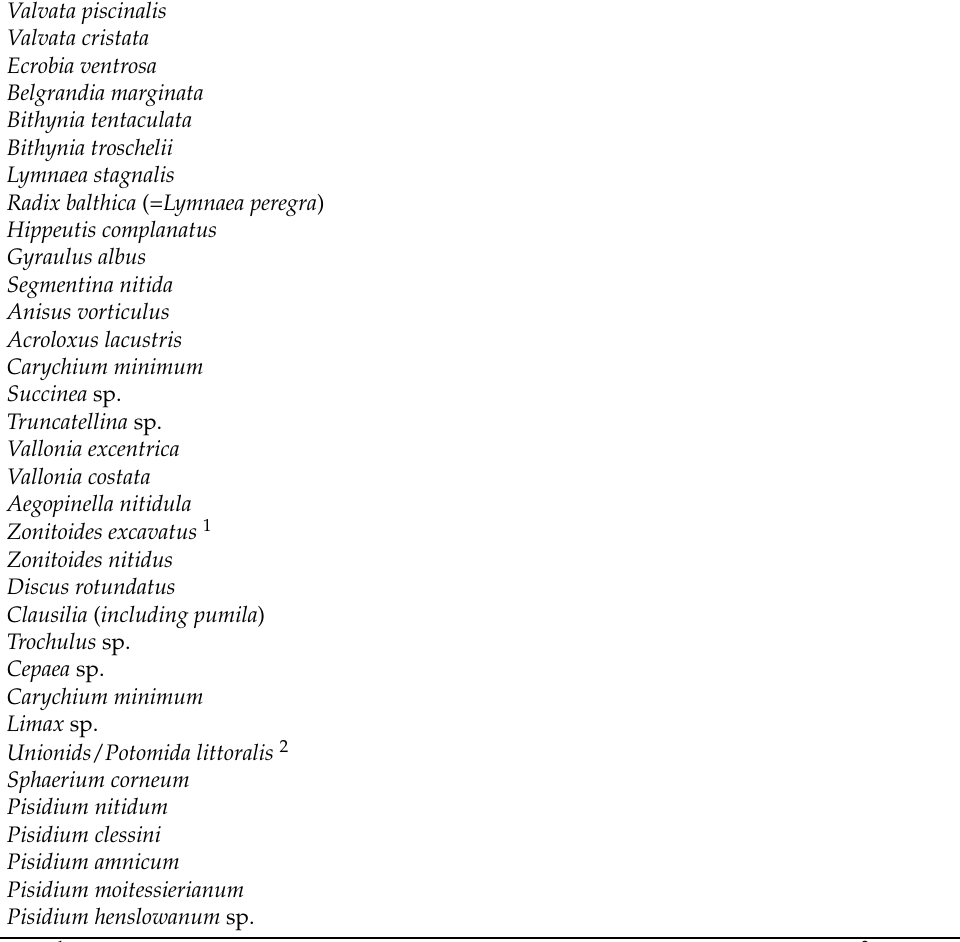
Table 5. Mollusca from the Clacton Channel Deposits, Trafalgar Road (identified by Richard Preece,